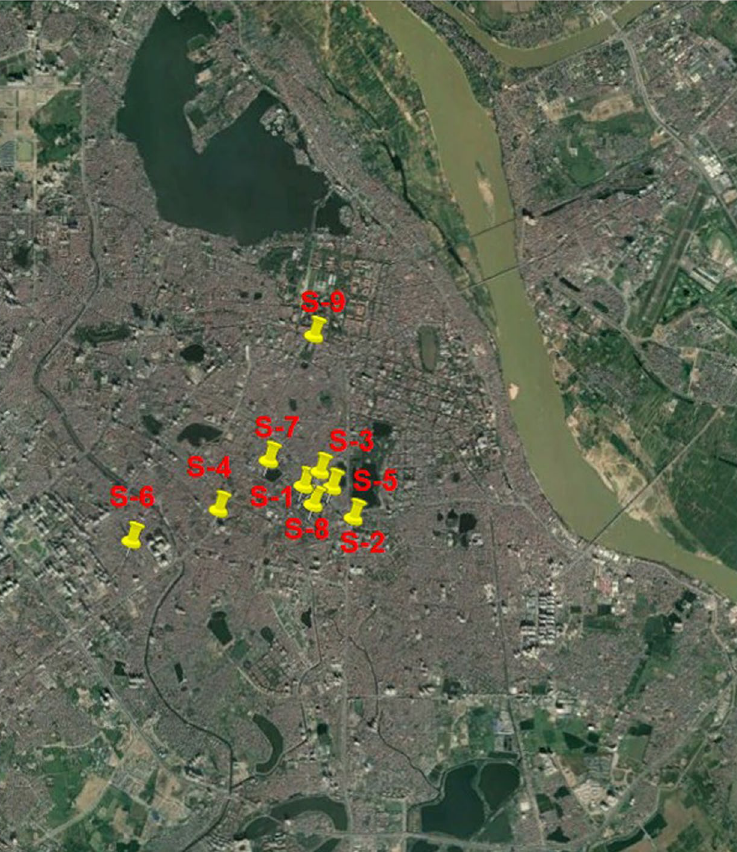
Figure 3. Referenced water depth from the flood event photos for 9 stations (background image map is obtained from the open source of Google Earth which data is from SIO, NOAA, U.S. Navy, NGA, GEBCO and image copyright belongs to 2012 Google, All the URL links of 9 stations are provided by Kha Dang- Dinh and Thanh Ngo-Duc). S-1: 0.47 m Website: First photography of https://vnexpress.net/tin-tuc/thoi-su/ nguoi-ha-noi-cam-nhan-ve-ngap-lut-lich-su-2111640.html. S-2: 0.06 m Website: First photography of http://khoahoc.tv/ha-noi-doi-mat-voi-nguy-co-ngap-lut-38265. S-3: 0.1 m Website: It is named Xe buýt tắc nghẽn of https://thethaovanhoa.vn/xa-hoi/anh-doc-so-sanh-tran-mua-lon-o-ha-noi-voi-tran-lut-lich-su- nam-2008-n20160526192312704.htm. S-4: 0.7 m Website: Fourth photography of http://blog.tamtay.vn/